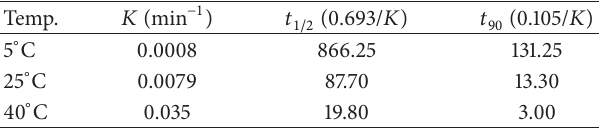
Table 4: 𝐾 , 𝑡 1/2 , and 𝑡 90 values for colistin degradation at pH 9 at different temperatures (5, 25, and 40 ∘ C).